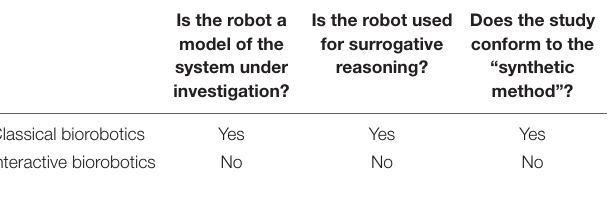
TABLE 1 | Methodological differences between classical and interactive